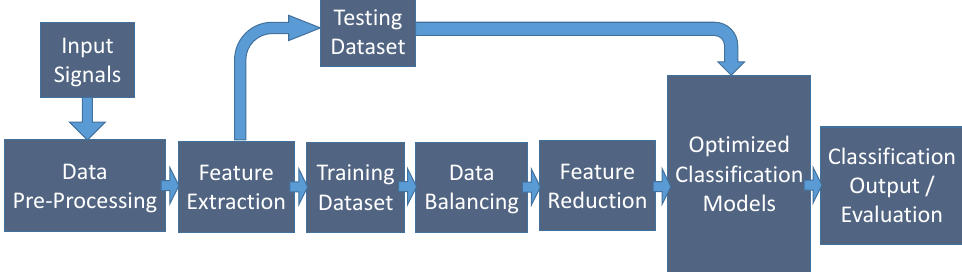
Figure 14. Block diagram representation of data-based fault diagnosis